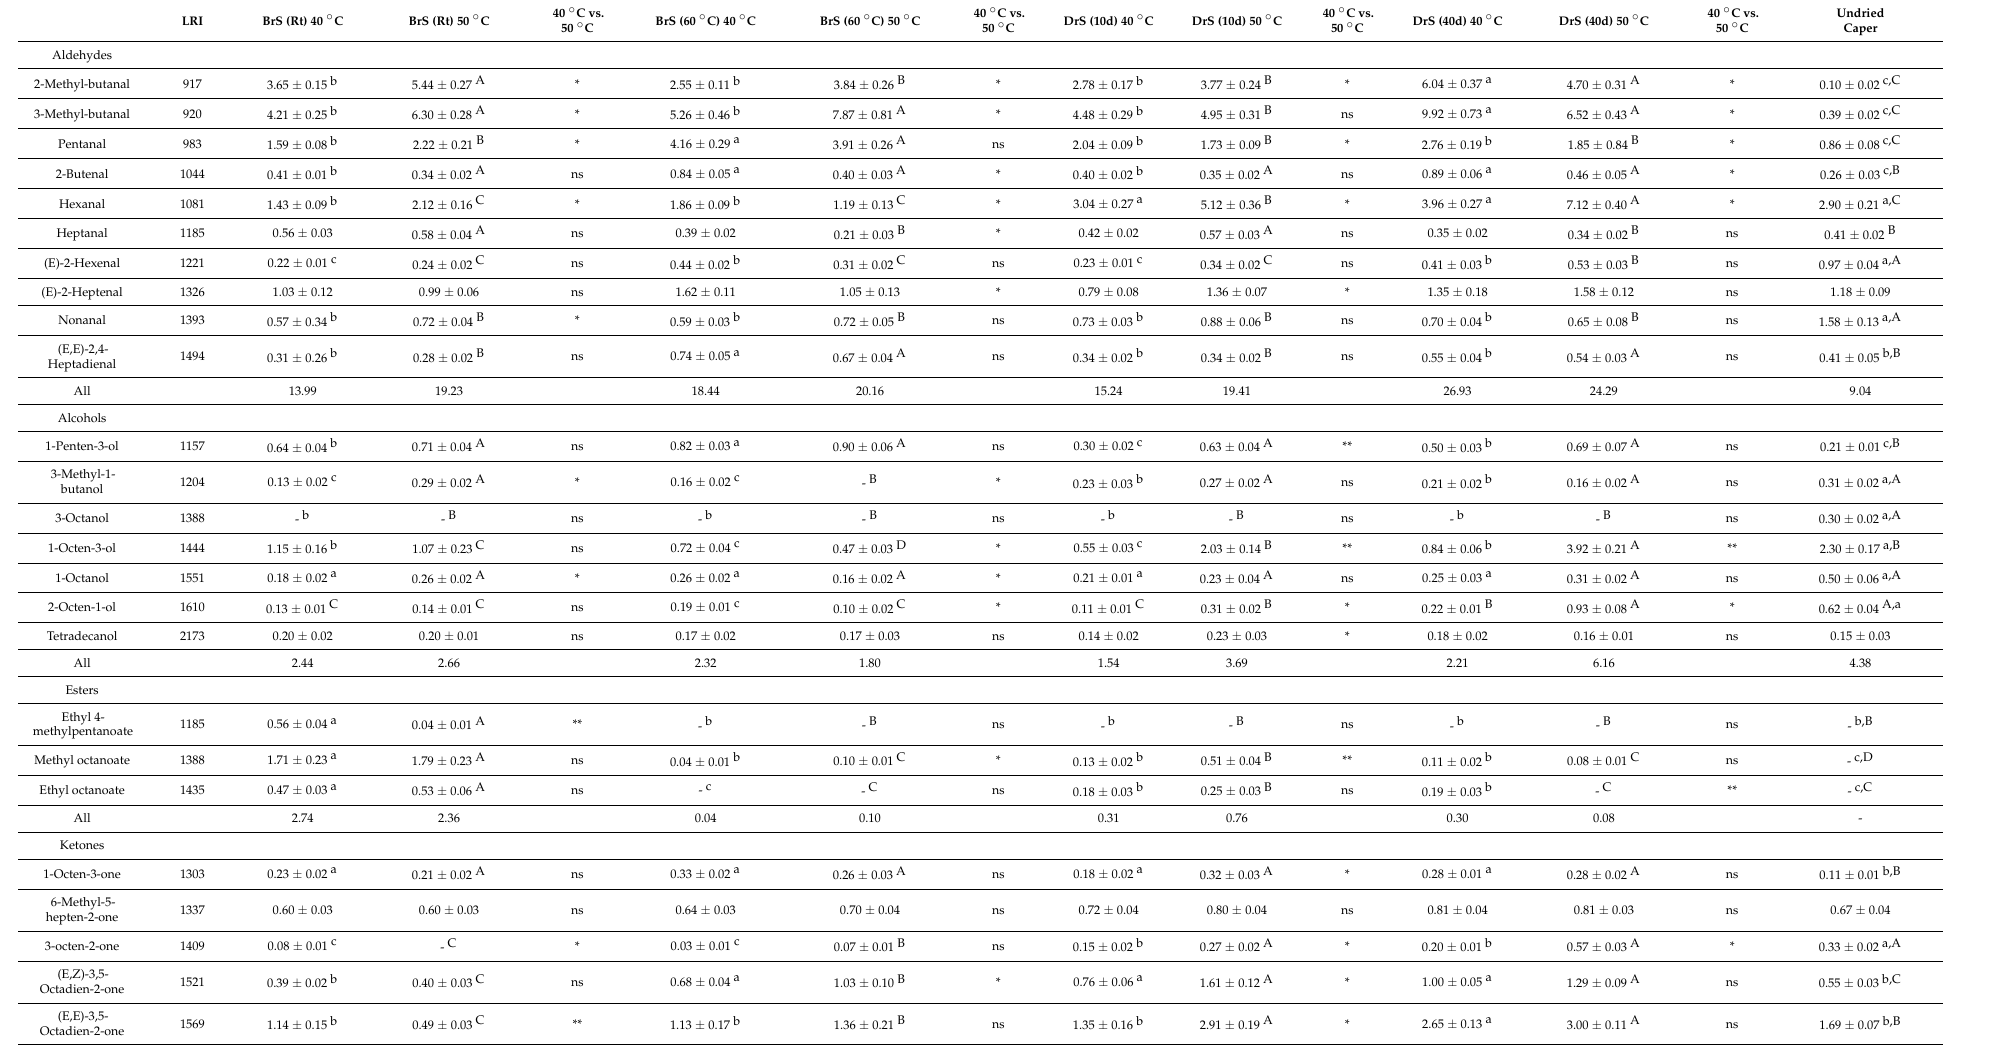
Table 2. Volatile aroma compounds (Area %) identified in caper powder samples obtained from the different